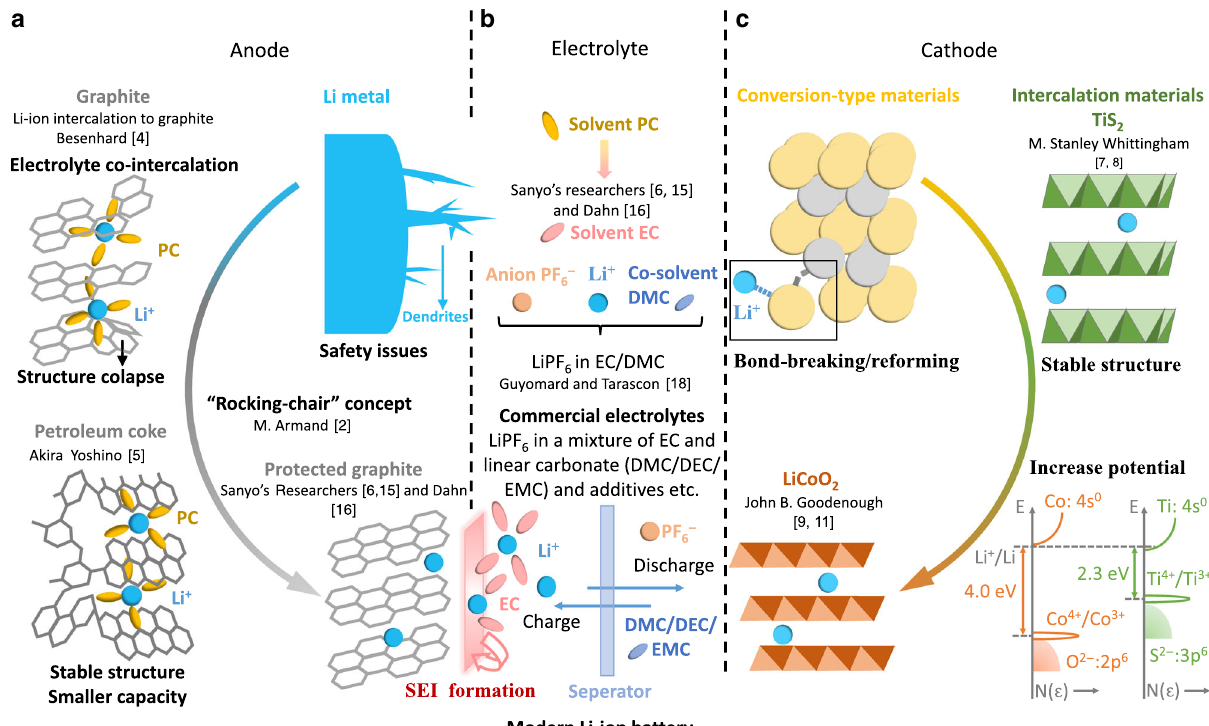
Fig. 1 Milestone discoveries that shaped the modern lithium-ion batteries. The development of ( a ) anode materials including lithium metal, petroleum coke and graphite, ( b ) electrolytes with the solvent propylene carbonate (PC), a mixture of ethylene carbonate (EC) and at least one linear carbonate selected from dimethyl carbonate (DMC), diethyl carbonate (DEC), ethyl methyl carbonate (EMC) and many additives, ( c ) cathode materials including conversion-type materials, intercalation materials titanium disul fi de (TiS 2 ) and lithium cobalt oxide (LiCoO 2